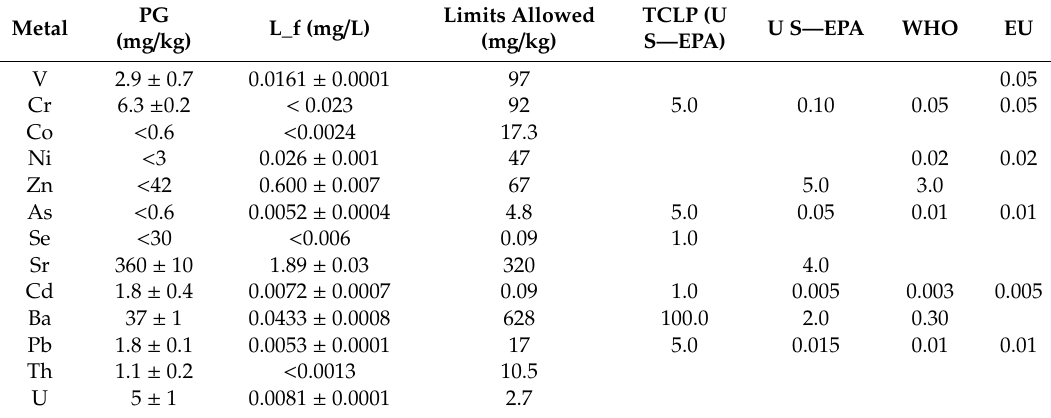
Table2. Contentsoftraceelements(mg / kg)inthePG(phosphogypsum)sample. Leachingresults(mg /